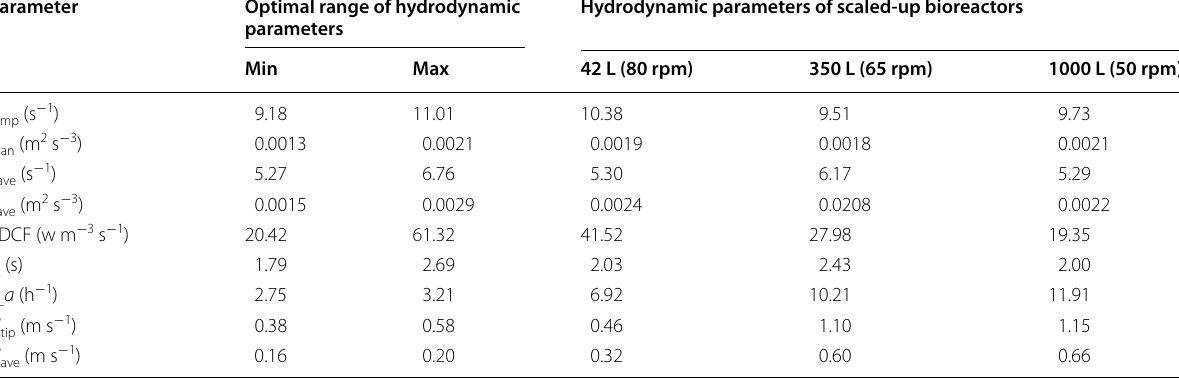
Table 5 The hydrodynamic parameters of large-scale bioreactors at the agitation speed calculated as the desirable hydrodynamic environment for the culture of BHK-21 cells